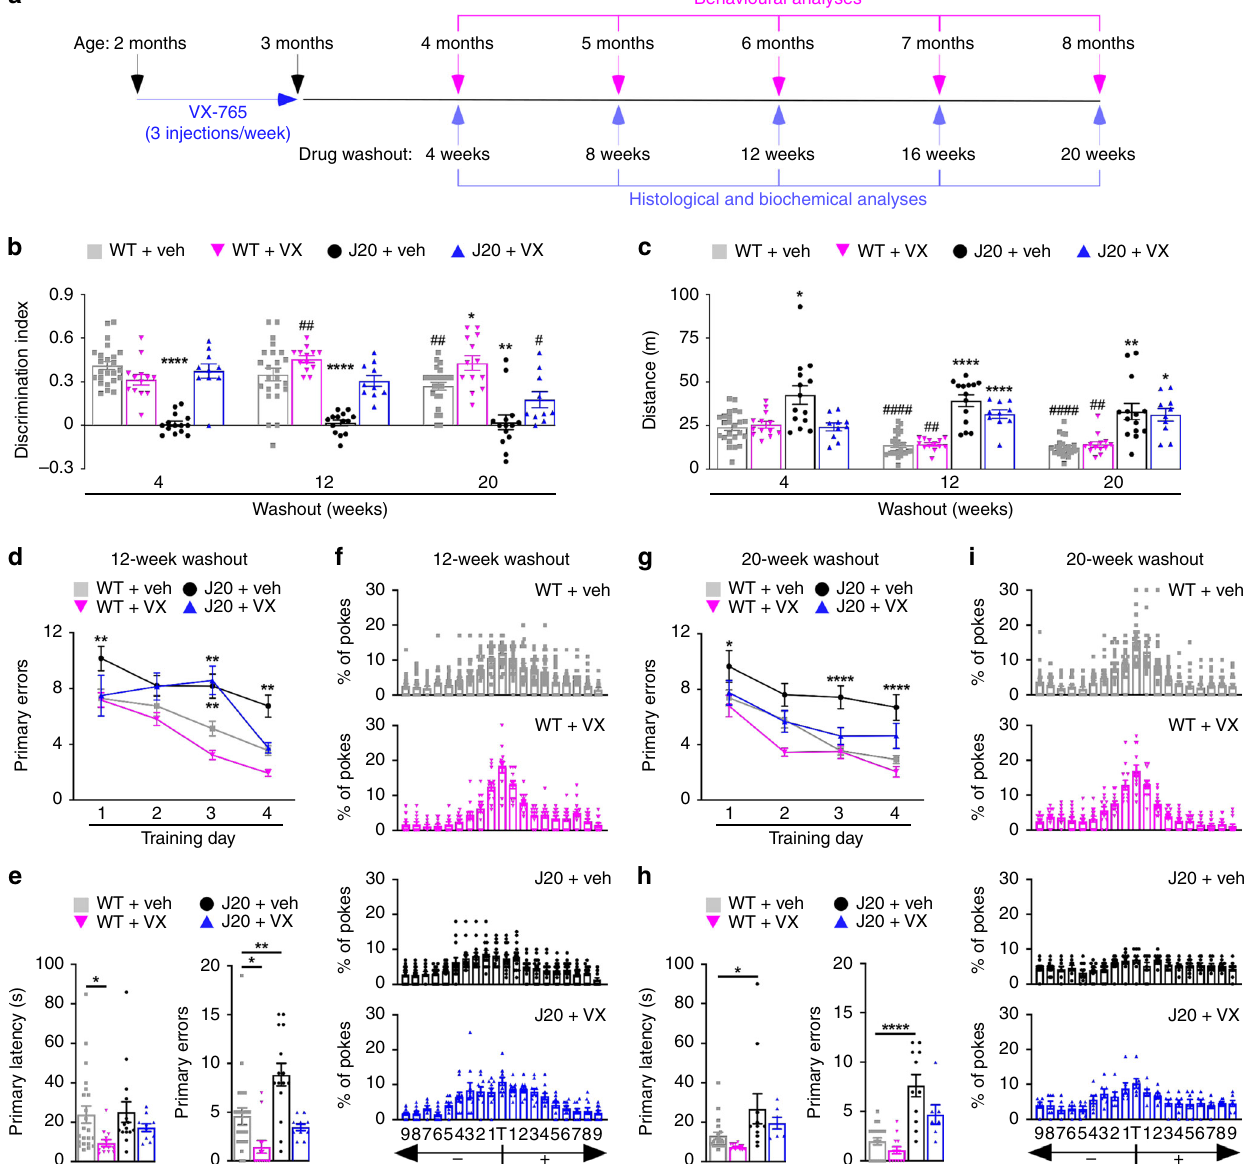
Fig. 2 Pre-symptomatic VX-765 treatment delays cognitive de fi cits in J20 mice. a Schematic diagram showing treatment and behavioural assessment.